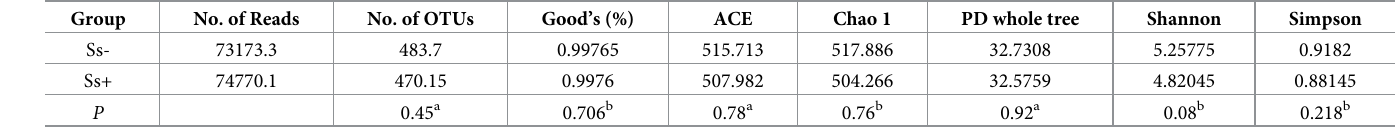
Table 2. Alpha diversity of the gut microbiota in Ss- and Ss+ groups, calculated according to several indices. Group No. of Reads